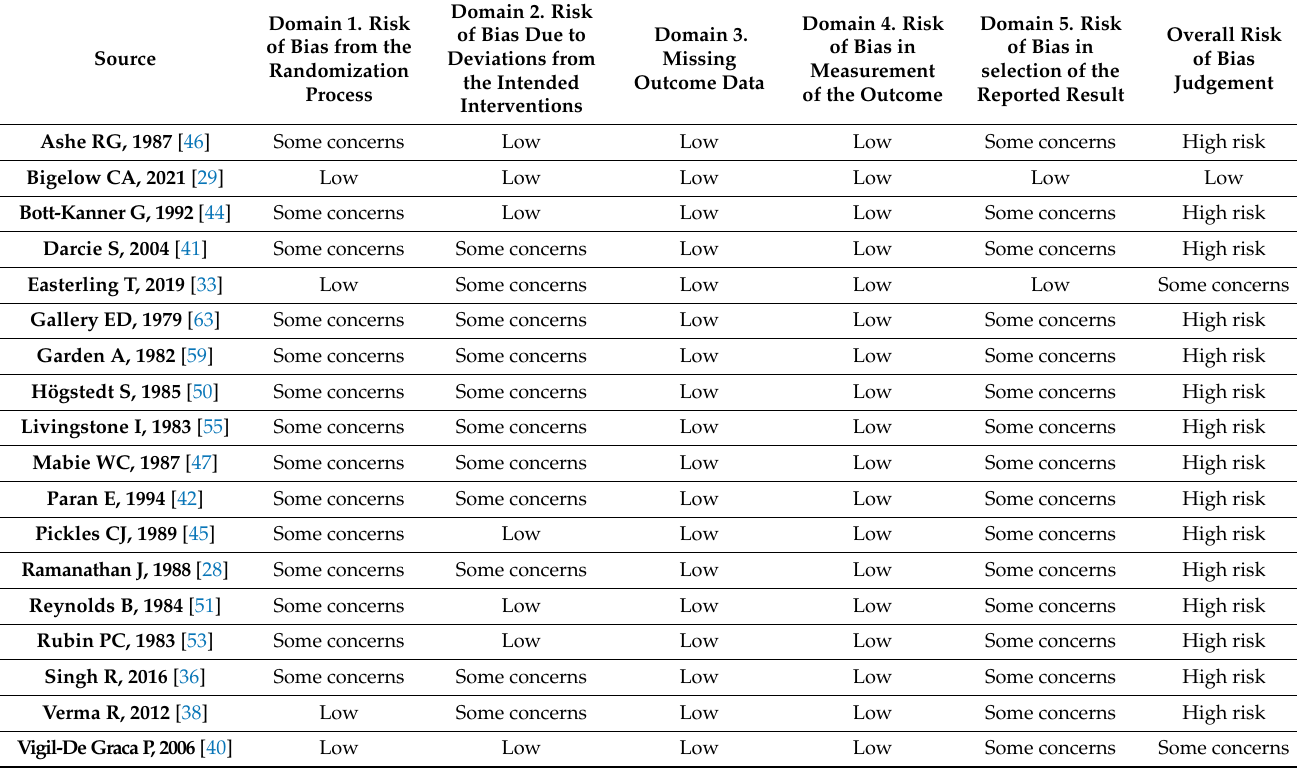
Table 4. Risk of bias in 18 randomized controlled